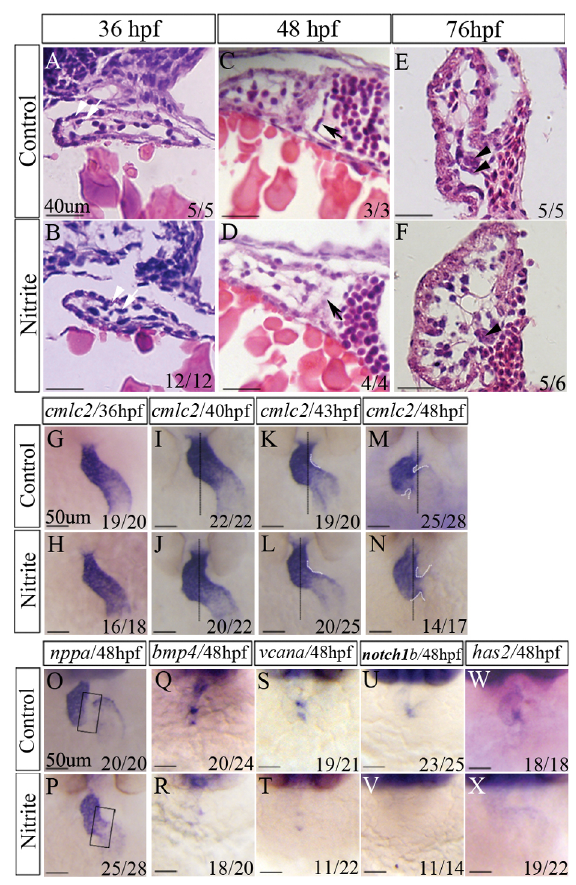
Figure 3. Histological and molecular analyses revealing excessive nitrite affected zebrafish heart valve development directly. Nitrite-exposed embryos were treated with 100 mg/l sodium nitrite from 10 hpf. (A–F) Histological sections showing defective valve development caused by nitrite exposure occurred from 48 hpf. At 36 hpf, the embryos exposed to nitrite exhibited similar histological heart structure (B) to that of control zebrafish, comprising one layer of myocardium and one layer of endocardium (A). At 48 hpf, endocardial cells of control embryos exhibited cuboidal shape in AVC between two chambers (C) but the exposed embryos did not have cuboidal endocardial cells in AVC (D). At 76 hpf, invagination of endocardial cells into cardiac jelly in AVC in control embryos formed superior primitive valve leaflet consisting of multilayer of cells (E); however, no superior primitive valve leaflet (no multilayer cells in the superior part of AVC) was formed in nitrite-exposed embryos (F). (G–N) Cardiac looping in zebrafish embryos shown by the expression of cmlc2 revealing abnormal cardiac looping caused by nitrite exposure occurred as early as 43 hpf. The expression pattern of cmlc2 was not affected by nitrite exposure at 36 hpf (G–H) and 40 hpf (I–J), but slightly abnormal (shown in white dotted curve) at 43 hpf (K–L) and obviously abnormal (shown in white dotted curve) at 48 hpf (M–N). (O–X) Nitrite exposures altered the expressions of molecular makers of valve progenitors at 48 hpf. nppa was not expressed in the AVC (rectangular box) of control embryos (O) but was ectopically expressed in the AVC of nitrite- exposed embryos (P). Compared to control embryos, nitrite exposure significantly decreased or abolished expressions of bmp4 (Q, R), vcana (S, T), notch1b (U, V) and has2 (W, X) in AVC. The number shown in the lower right-hand corner was the number of embryos exhibiting the typical phenotype shown in the panel to the number of embryos totally observed. Black arrow: position of cuboidal endocardial cells; Black arrowhead: position of superior primitive leaflet; White arrow: endocardium; White arrowhead: myocardium.